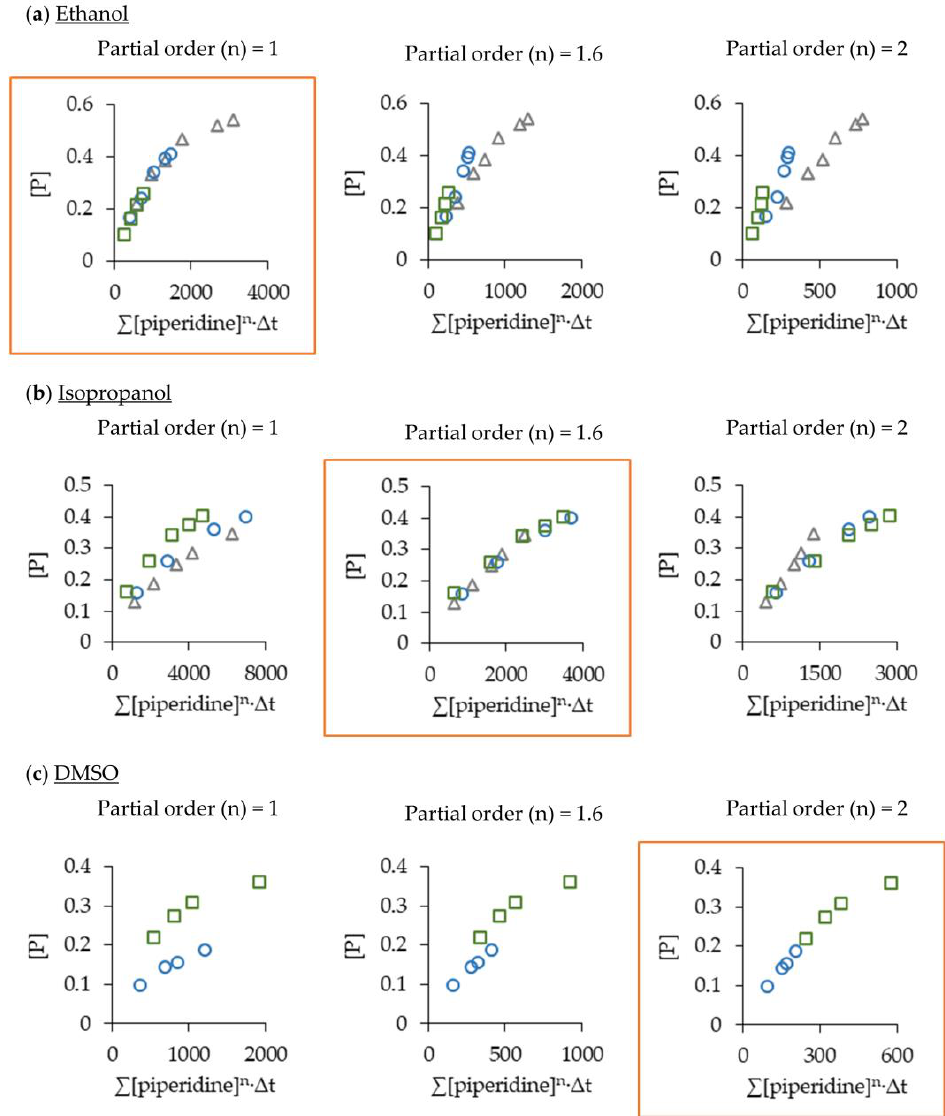
Figure 1. Variable Time Normalization Analysis of an aza-Michael addition to establish the partial order of reaction with respect to piperidine concentration. ( a ) In ethanol; ( b ) In isopropanol; ( c ) In dimethyl sulfoxide (DMSO). Data symbols refer to separate experiments performed at different initial concentrations (see Supplementary Material S3). Graphs in a box correspond to the correct partial reaction order (n = 1, 1.6, or